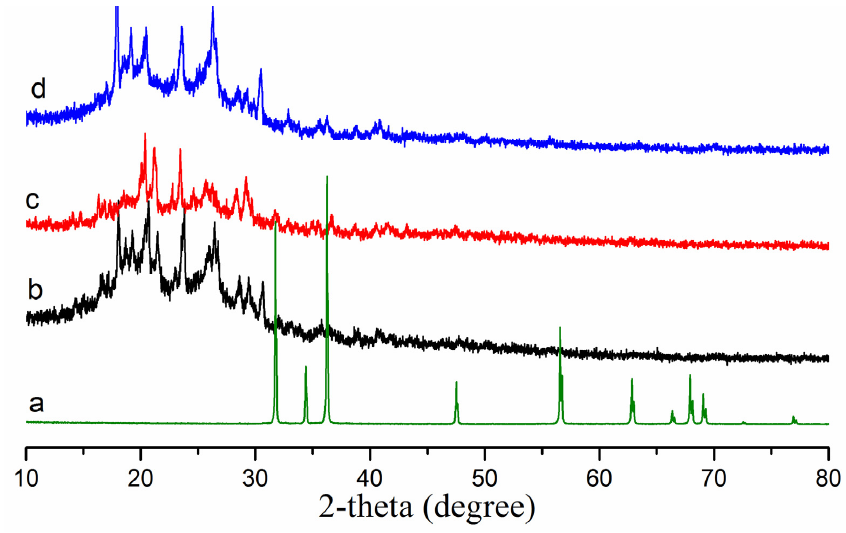
Figure 2. XRD patterns of ZnO ( a ) and PANI composites with the different amounts of ZnO, ( b ) 0%; ( c ) 8% and ( d ) 16%.